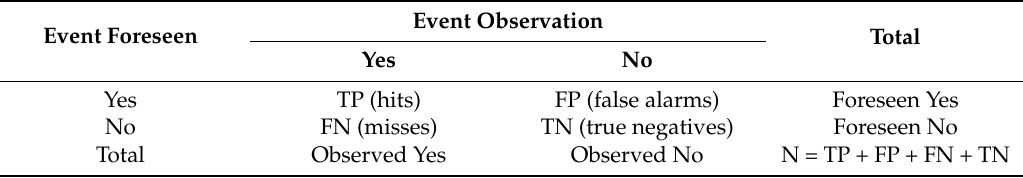
Table 2. Schematic 2 × 2 contingency table for wind power ramp detection